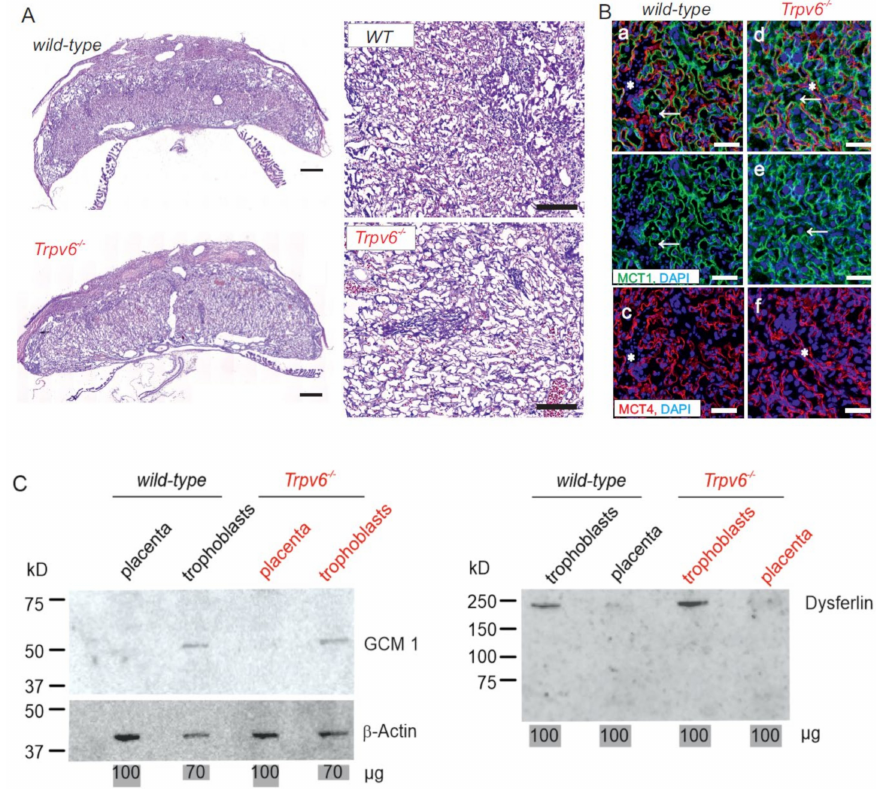
Figure 1. The Trpv6 - / - placental labyrinth structure is less compact. ( A ) Hematoxylin–eosin staining of murine wild-type and Trpv6 - / - placenta sections (left) and two enlarged sections from two other placentae of the labyrinth zone (right) at E14.5 are shown. Scale bar: placenta (left), 500 µ m; labyrinth zone (right), 200 µ m. ( B ) Immunostaining of the placental labyrinth zone from wt and Trpv6 - / - at E14.5 with antibodies against monocarboxylate transporters 1 and 4 (MCT1, MCT4), the marker proteins of syncytiotrophoblast layers 1 and 2, respectively. The immunoreactivity for MCT1 (green signal) was detected in syncytiotrophoblast I cell layer which faced the maternal blood sinuses (arrow) and for MCT4 (red signal) in syncytiotrophoblast II cells which faced the fetal blood vessels (*), blue, DAPI stain, scale bar = 50 µ m. ( C ) Western blot of protein lysates from 100 µ g placenta and 70 µ g trophoblast were tested for the presence of the trophoblast marker chorion-specific transcription factor GCMa (GCM1) and dysferlin. Antibody against beta-actin was used as loading